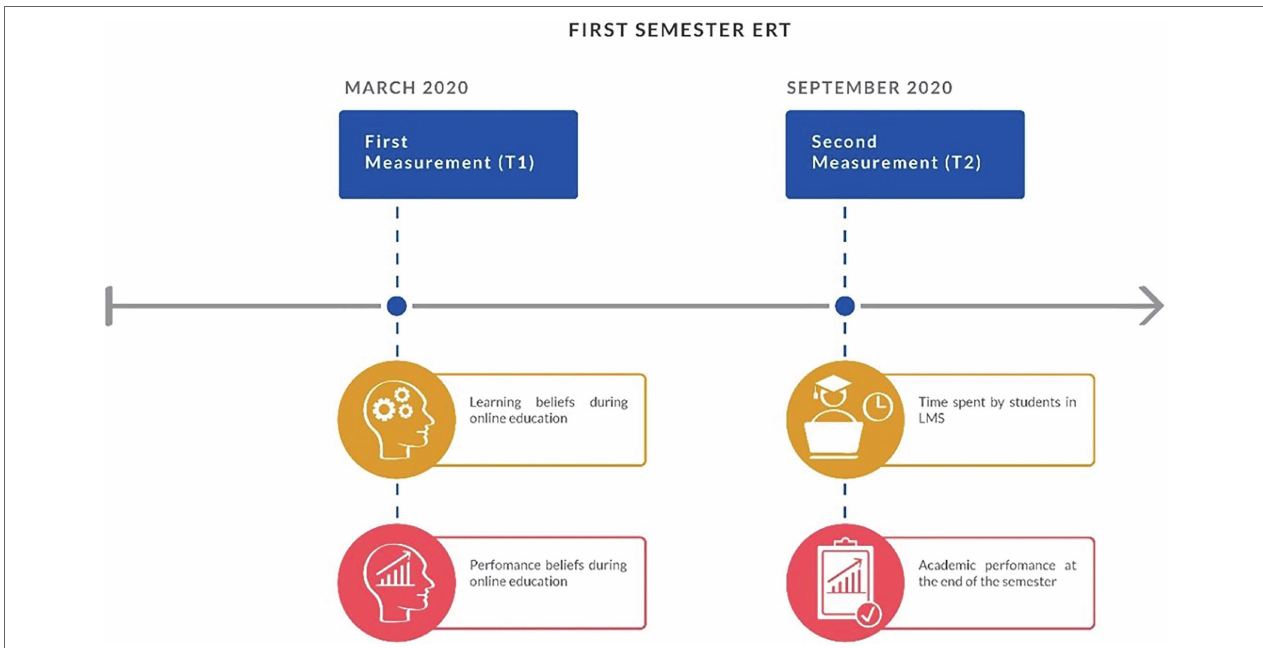
FIGURE 1 | Description of the measurement moments carried out in the